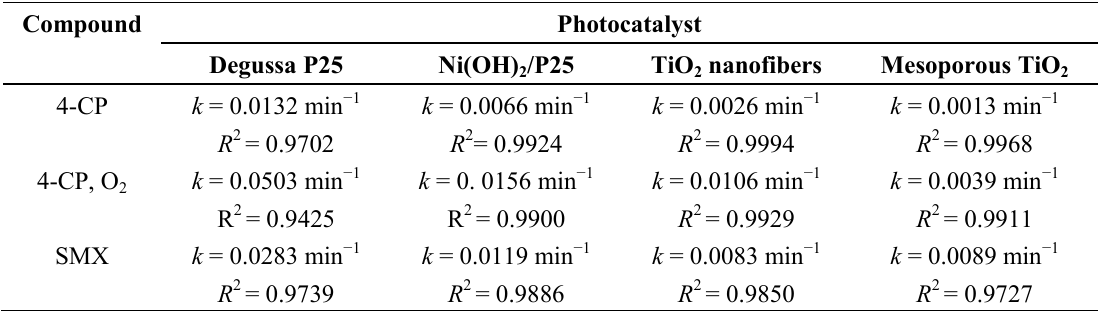
Table 1. Pseudo first order rate constants and R 2 for 4-CP (with and without O and